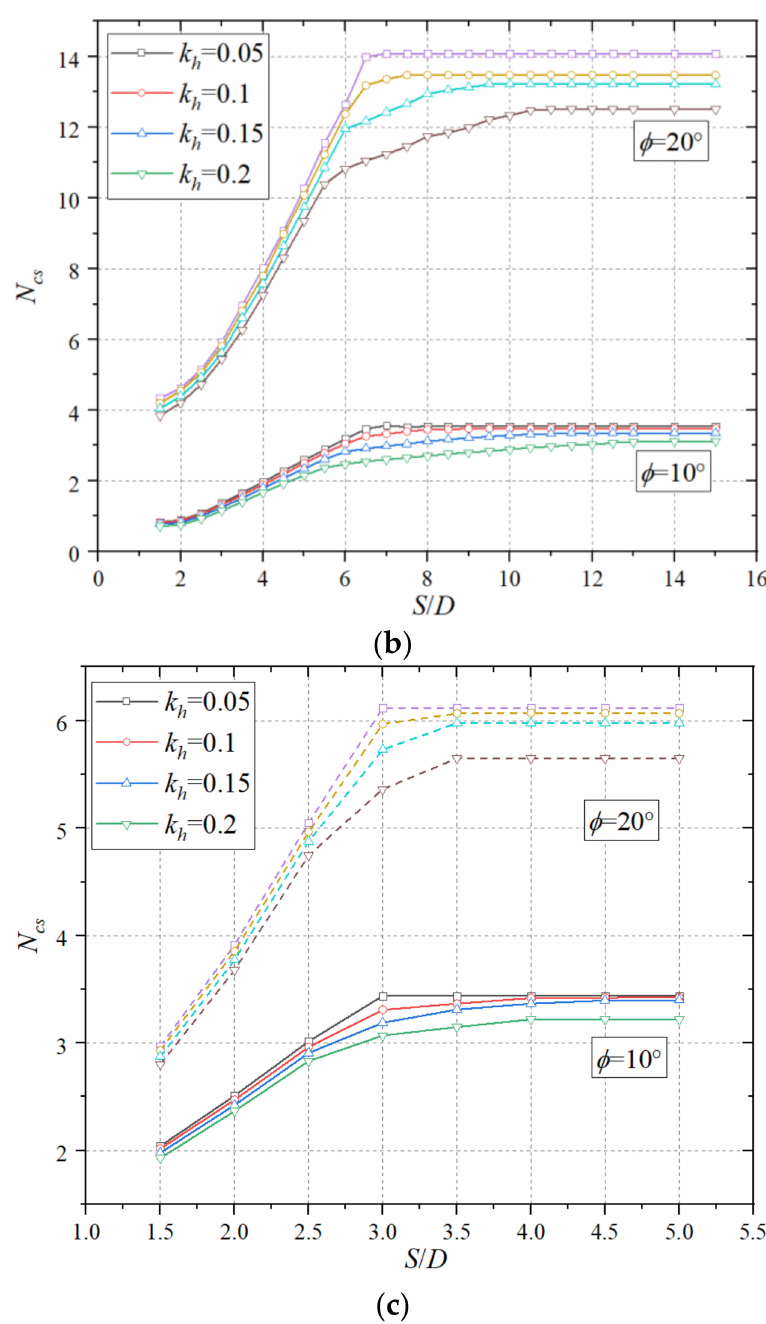
Figure 5. N cs - S / D curves with different k h and ϕ for ( a ) γ D / c = 1, H / D = 1; ( b ) γ D / c = 1, H / D = 3; and ( c ) γ D / c = 0, H / D =